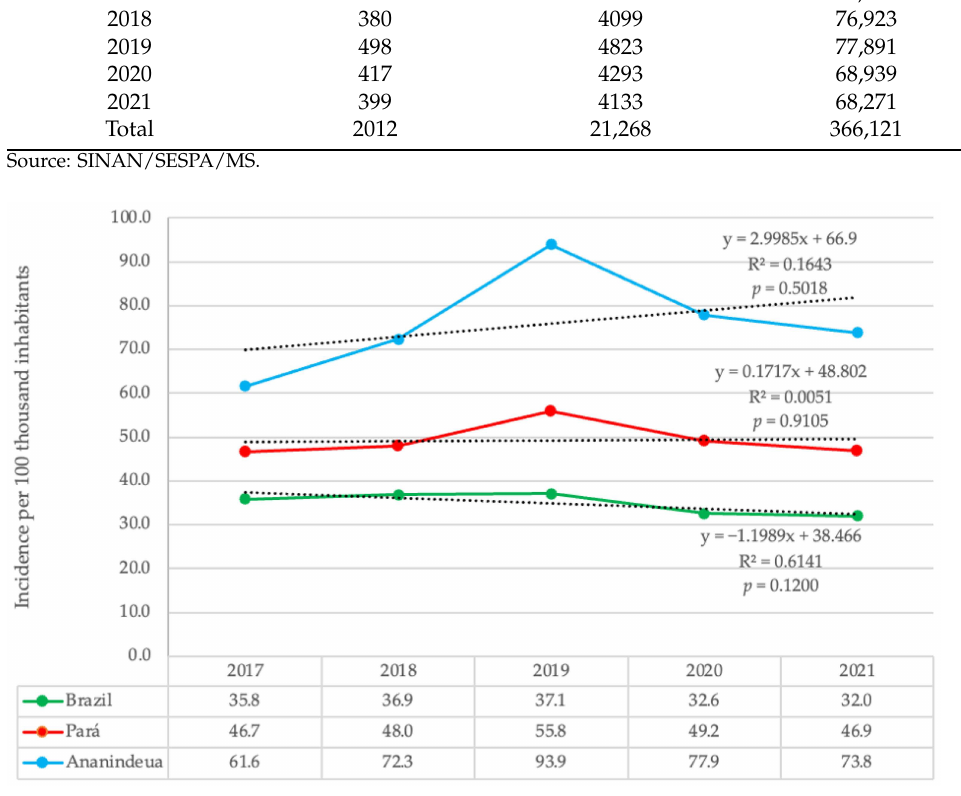
Figure 1. Trend of TB incidence coefficient in the Municipality of Ananindeua, state of Par á and Brazil from 2017 to 2021. Trend line represented by the dashed